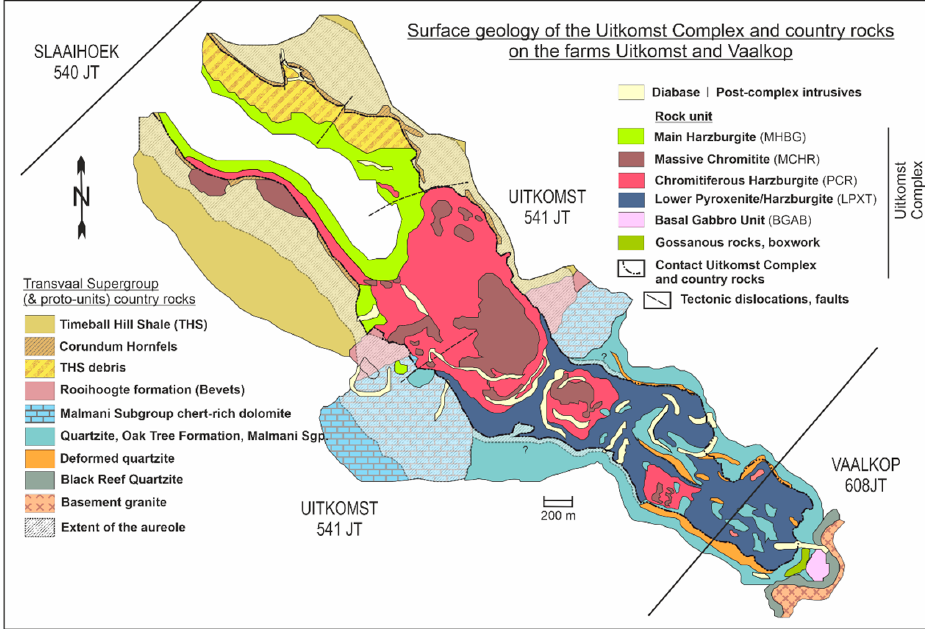
Figure 2. Local geological map of the Uitkomst Complex on the farm Uitkomst (UK) with the contact metamorphic aureole (combined map after [4]).